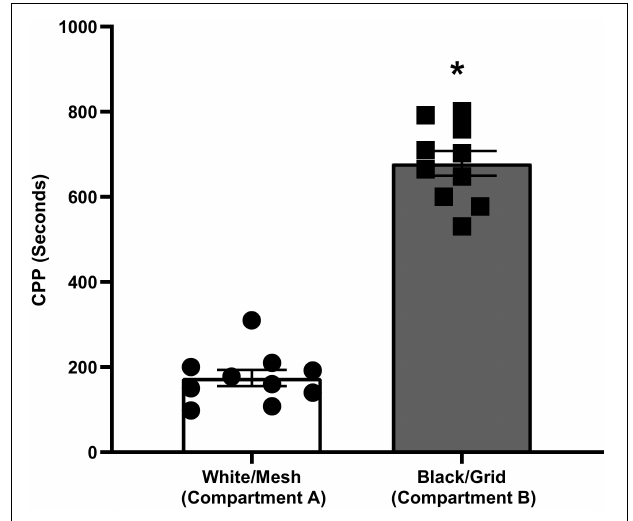
FIGURE 2 | Conditioned place preference of rats during pretesting (* p < 0.001, Student’s t -test).